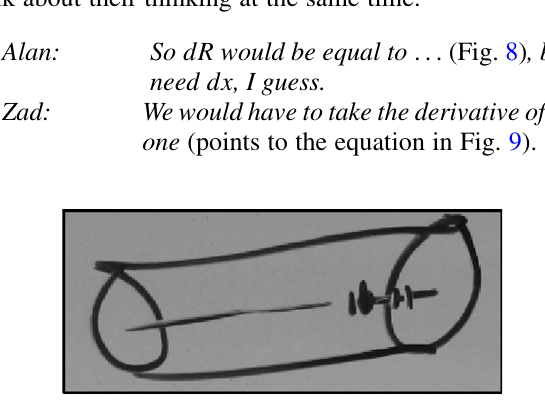
resistance.FIG. 7. Picture drawn by